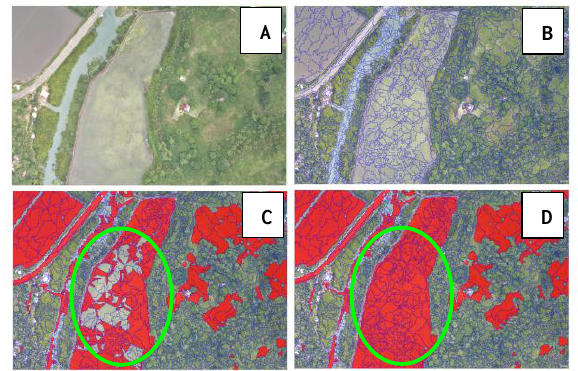
Figure 3. Orthophotographs before (A) and after (B) multi- resolution segmentation. Flat Surfaces classification using assign class algorithm with mean Slope maximum and minimum threshold values of 10 (C) and then 100 (D).